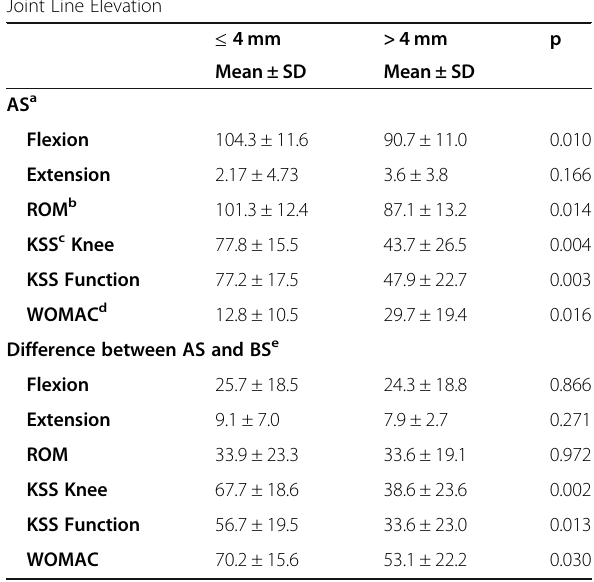
Table 4 Joint Line